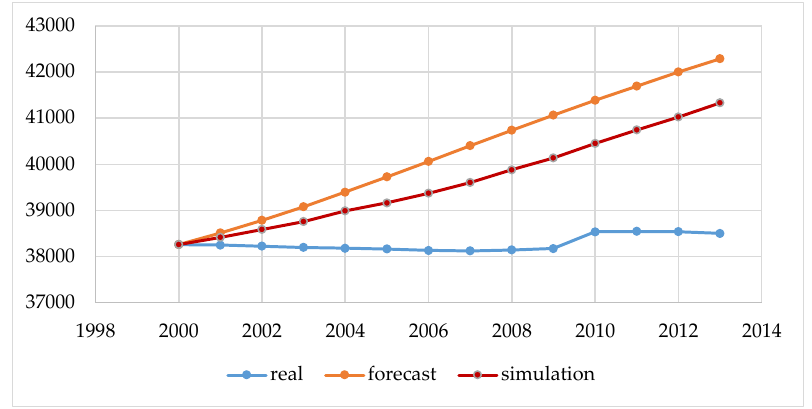
Figure 4. The demographic forecast of Poland (population in thousands). Source: own study based on CSO, EUROSTAT, LSD [24 – 28,36].